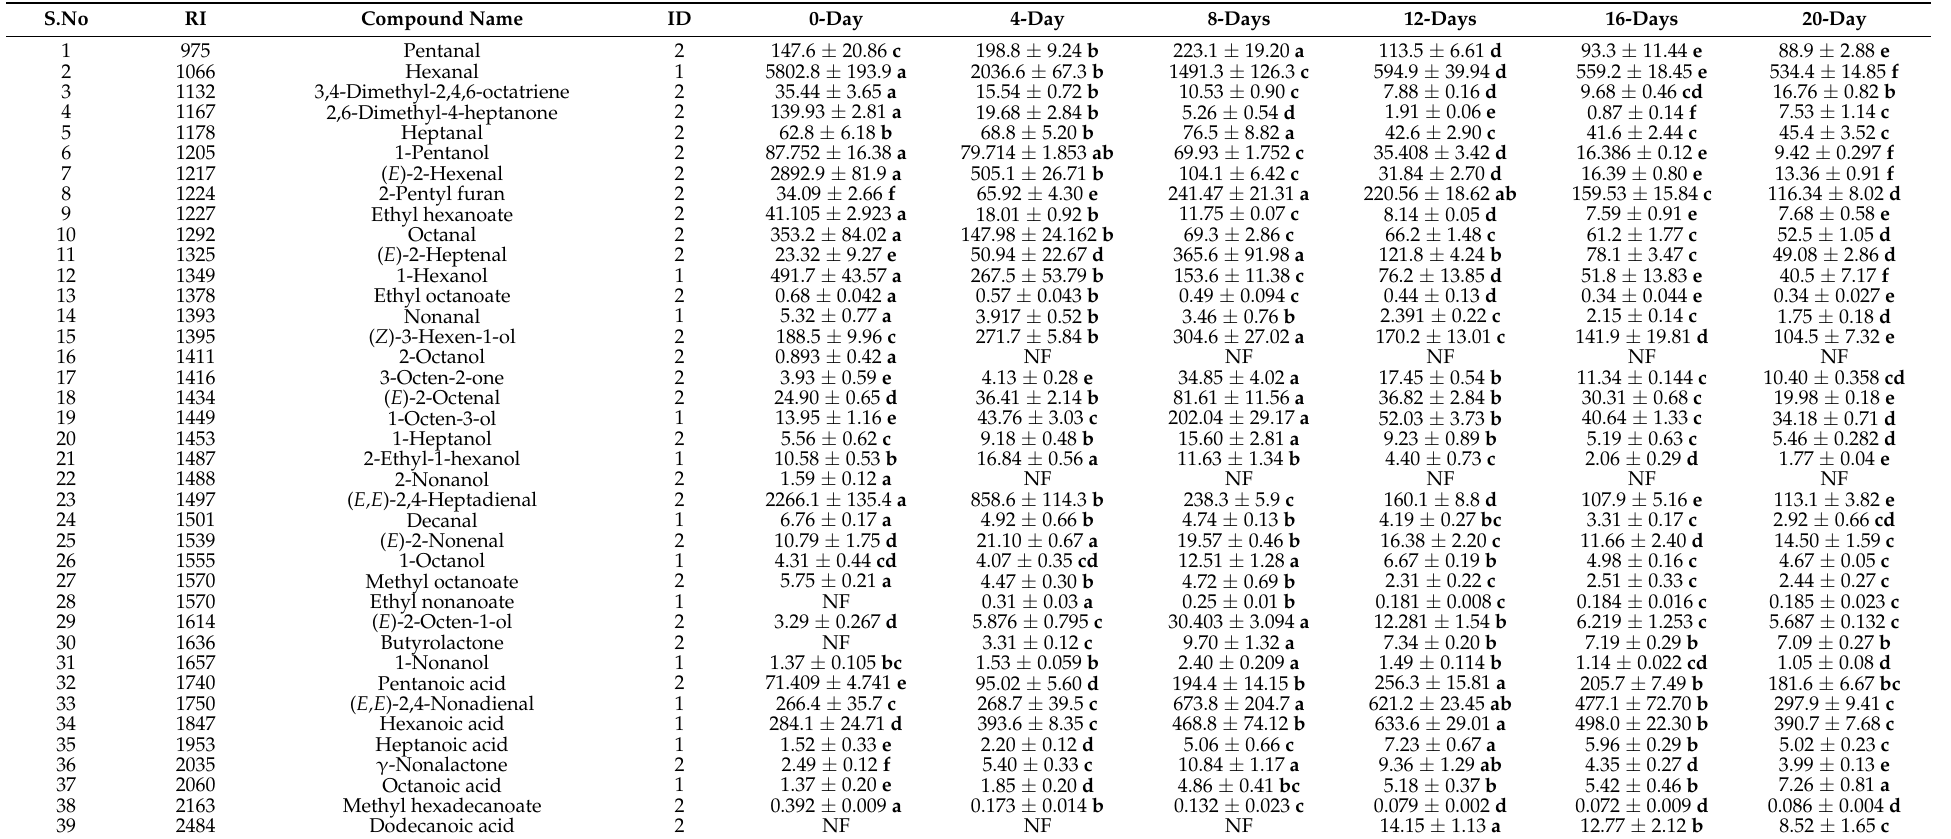
Table 1. The concentration ( µ g/L) of UNFO-derived compounds in ‘Thompson Seedless’ at different days of